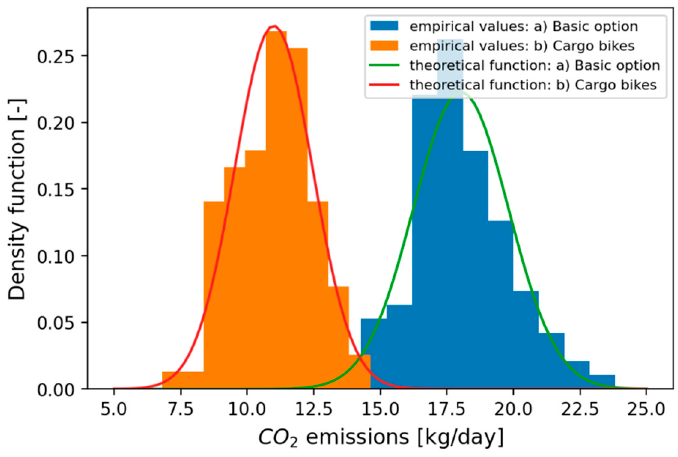
Figure 8. Distribution of the CO 2 emissions based on the results of simulations for Dubrovnik.